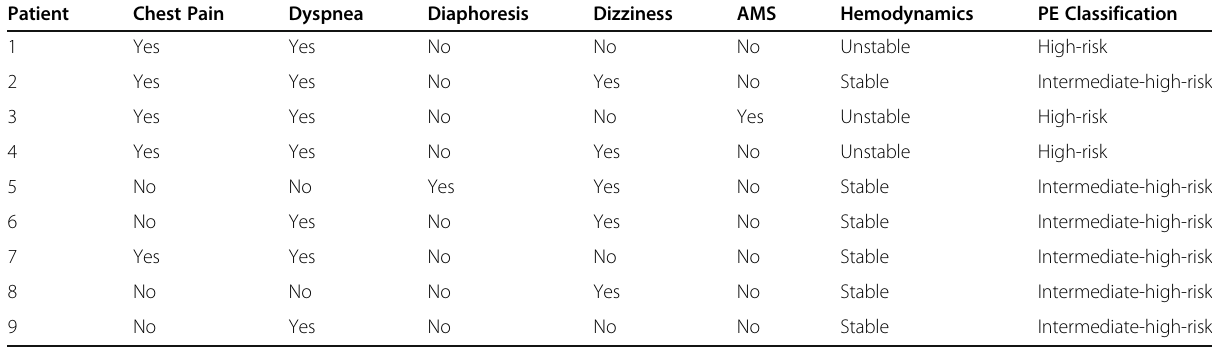
Table 1 Patient clinical presentations prior to mechanical thrombectomy Patient Chest Pain Dyspnea